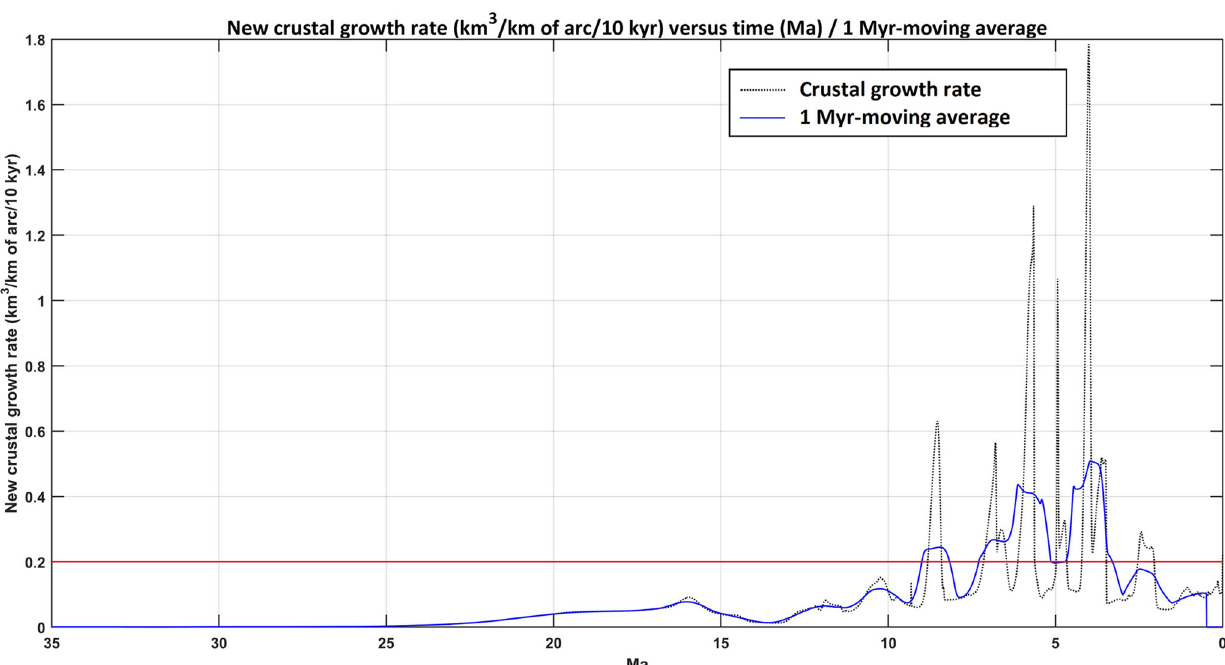
Fig. 4 Crustal growth rate (in km 3 per km of arc per 10 kyr) versus time (in Ma) for the 22.5 – 29°S segment of the Central Andes. Crustal growth rate is shown as a black dotted line, with respect to which a moving average of 1 Myr, shown as a blue line, is calculated. The red horizontal line is drawn at 20 km 3 per km of arc per Myr (extrapolated to 10 kyr), proposed as re fl ecting the boundary between steady-state and fl are-up magmatism 5,13,21 . The data including the 2 σ range can be found in Supplementary Fig. 6. Moving averages for different time intervals are provided in Supplementary Data